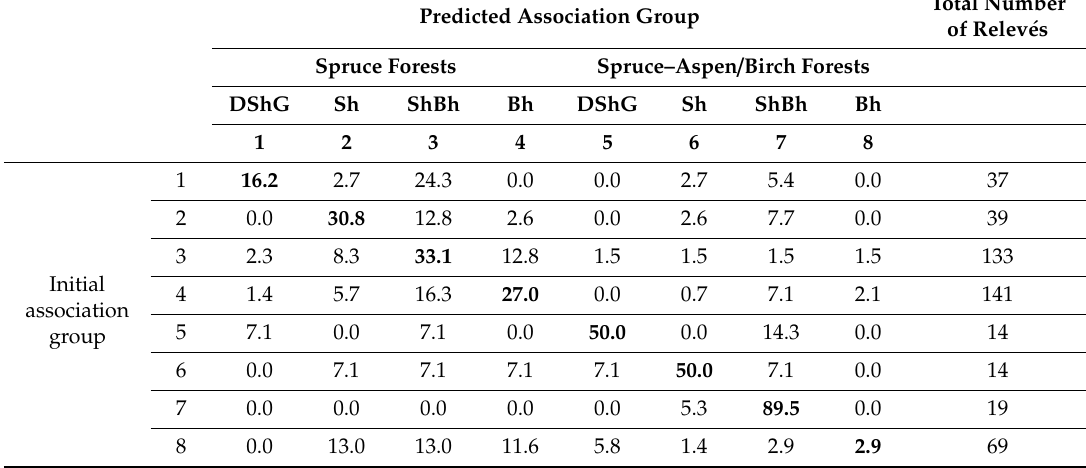
Table A2. Results of linear discriminant analysis (LDA) classification. Cells: percent of initial groups recognized correctly or as other